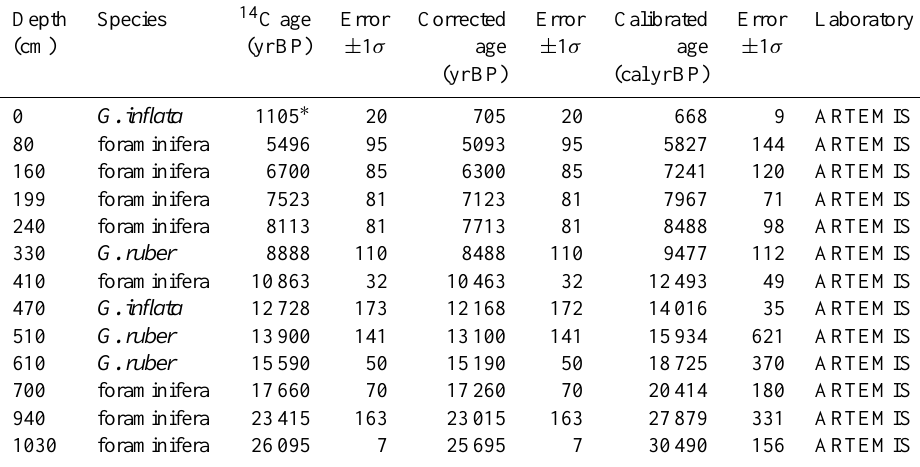
Table 1. Radiocarbon ages performed on core MD04-2797. The ages were corrected using reservoir ages of 400yr during the Holocene, the Younger Dryas and late glacial, 560yr during the Bølling–Allerød and 800yr during the Heinrich event H1 and the Older Dryas, following recommendations of Siani et al.